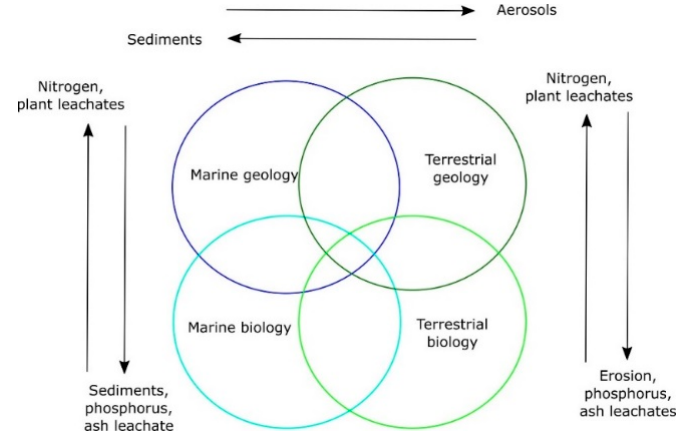
Figure 7. Diagram showing the interplay of marine and terrestrial processes that possibly affect the ecosystem response following a volcanic eruption (modified after De Gange et al. [88]).